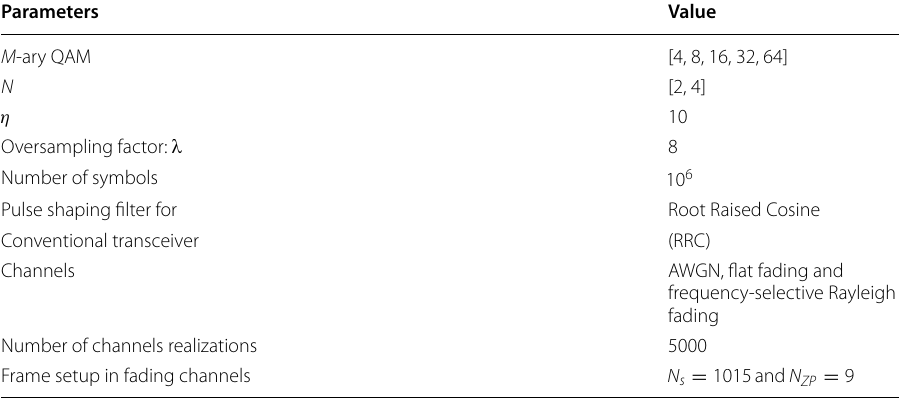
Table 1 Simulation